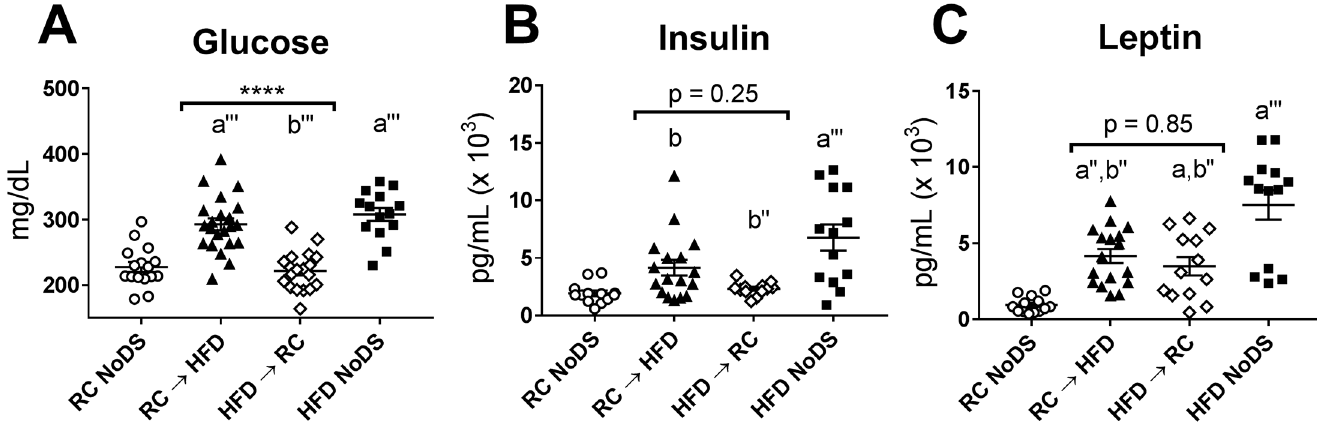
Fig 4. Glucose, insulin, and leptin levels from trunk blood plasma (Day 7 Post-DS). (A) Glucose, (B) insulin, and (C) leptin levels measured from blood plasma, which was collected immediately after sacrifice (ZT6-7). (cid:3)(cid:3)(cid:3)(cid:3) p < 0.0001 comparing RC ! HFD vs HFD ! RC; a: p < 0.05, a’: p < 0.01, a”: p < 0.001, a”‘: p < 0.0001 compared to RC NoDS; b: p < 0.05, b’: p < 0.01, b”: p < 0.001, b”‘: p < 0.0001 compared to HFD NoDS. Sample sizes for glucose: [RC NoDS: n = 16; RC ! HFD: n = 21; HFD ! RC: n = 19; HFD NoDS: n = 14]. Sample sizes for insulin: [RC NoDS: n = 13; RC ! HFD: n = 17; HFD ! RC: n = 12; HFD NoDS: n = 13]. Sample sizes for leptin: [RC NoDS: n = 13; RC ! HFD: n = 17; HFD ! RC: n = 13; HFD NoDS: n = 13].